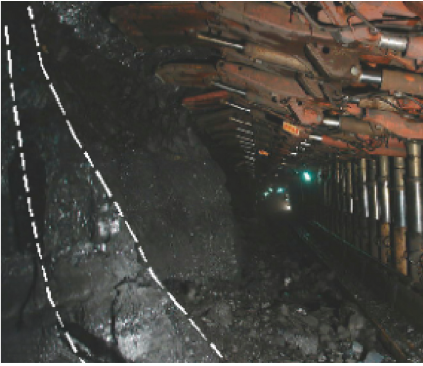
Figure 1: The field photo of coal wall